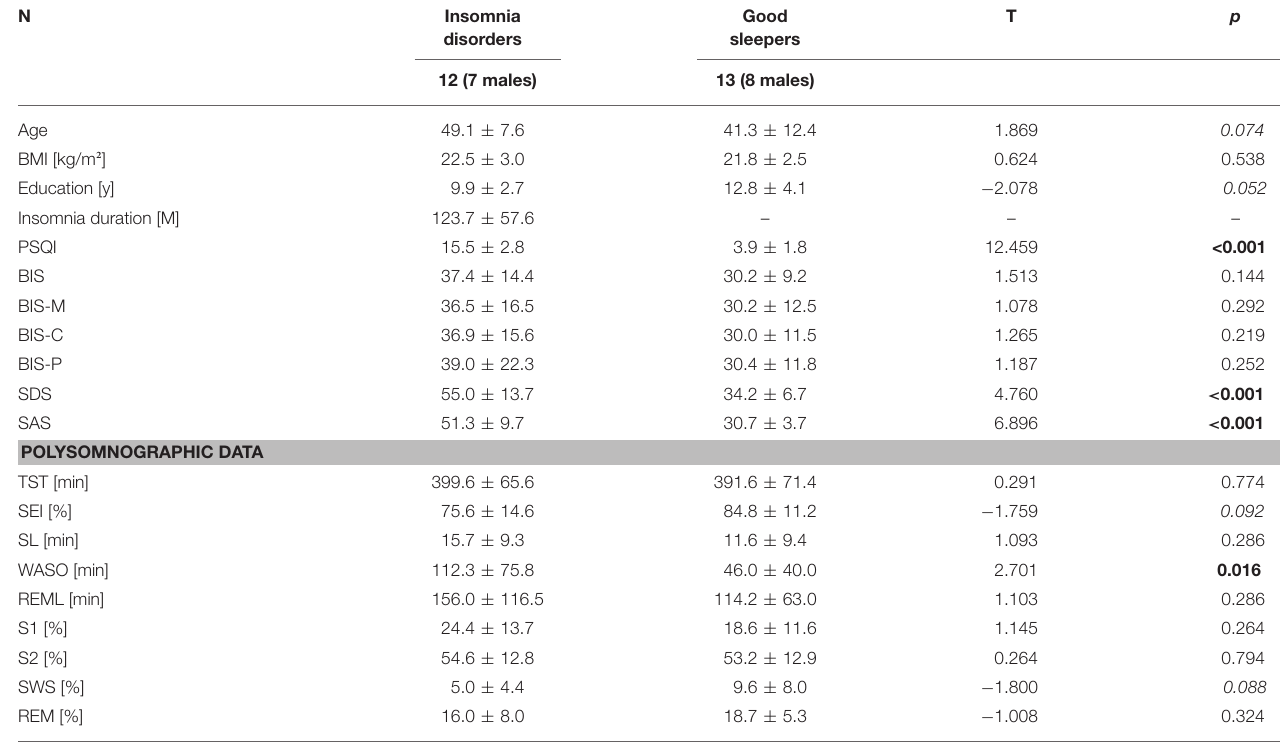
TABLE 1 | Descriptive statistic of demographic, clinical and polysomnographic